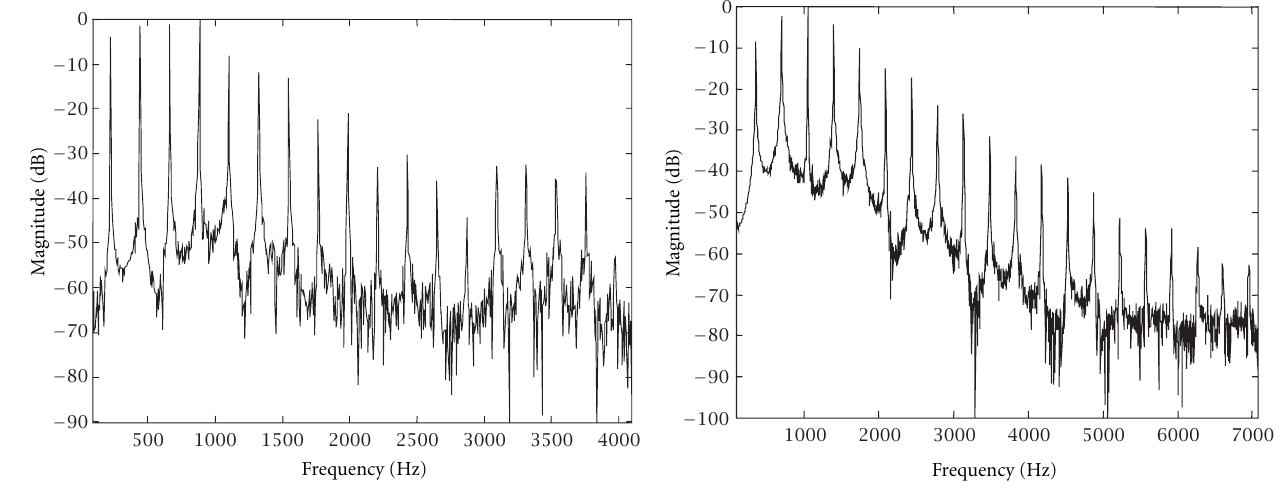
Figure 15: Synthesized oboe (287.5 Hz).